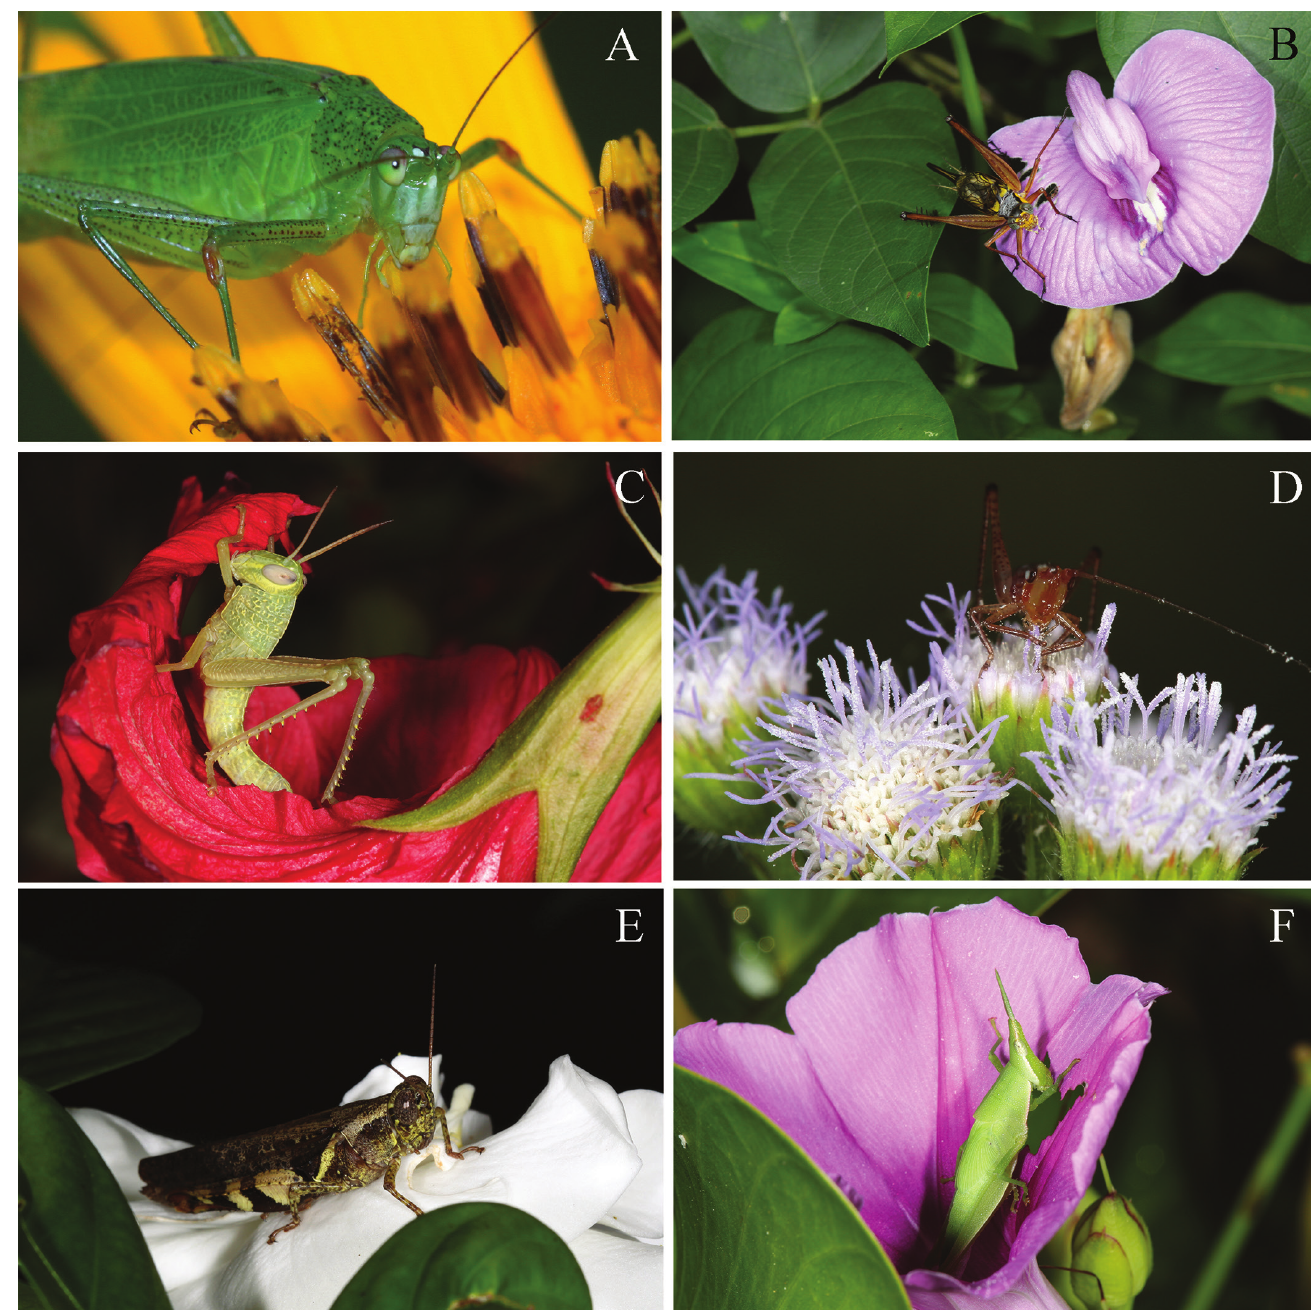
Fig. 3. Examples of common flower-visiting orthopterans from Southeast Asia: A. Phaneroptera brevis feeding on the anthers of Tithonia diversifolia in Bukit Larut, B. Nisitrus species feeding on the petals of Centrosema molle in Ulu Temburong, C. Valanga nigricornis feeding on a corolla lobe of Hibiscus rosa-sinensis in Pulau Tioman, D. Conocephalus species feeding on the florets of Ageratum conyzoides , E. Xenocatantops humilis feeding on a corolla lobe of Gardenia jasminoides in Singapore, and F. Atractomorpha species on the corolla of Ipomoea pes-caprae in Pulau Tioman .